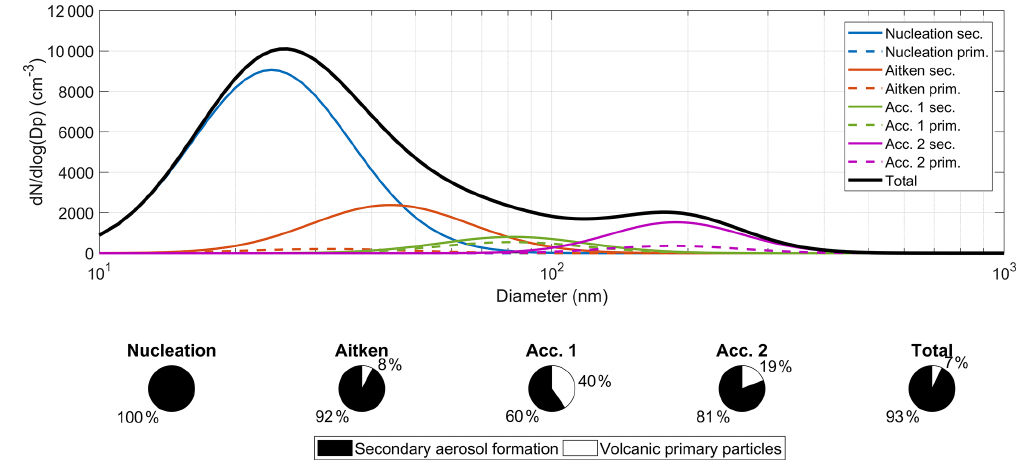
Figure 8. Size distribution of the particles of volcanic origin reconstructed using the spectra measured on plume and non-plume event days. The contributions of primary (i.e. formed or transformed via heterogeneous processes in the very close proximity of the vent) and secondary aerosols are shown separately for each mode on the spectrum and are further highlighted on the pie charts. The contribution of primary aerosols was evaluated based on the spectra measured at 07:00LT under in-plume and off-plume conditions, while the contribution of secondary aerosols was deduced from the maximum concentrations measured for each mode under in-plume and off-plume conditions, between 11:00 and